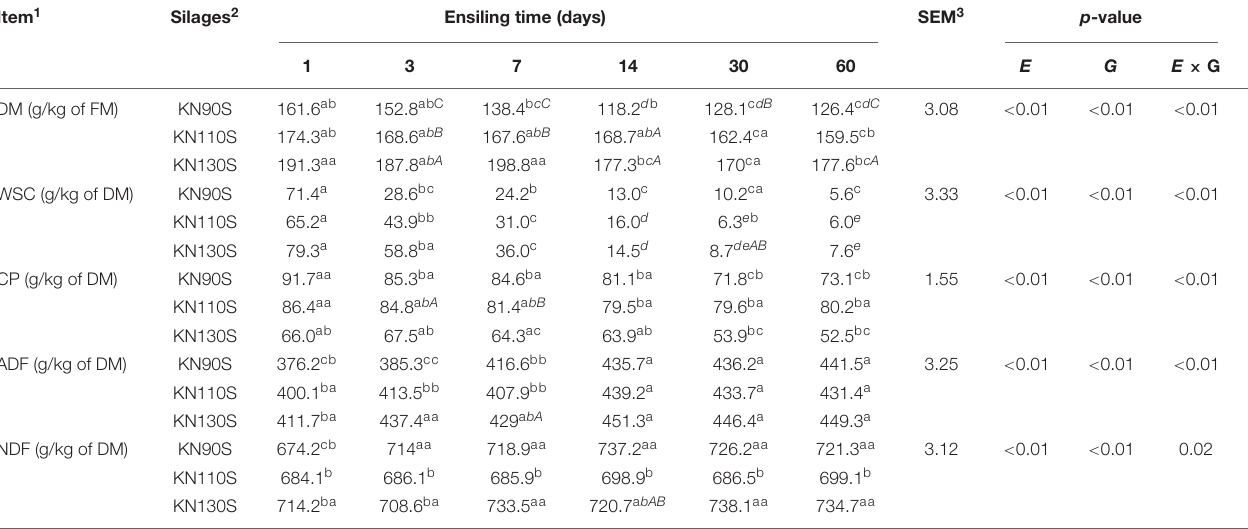
TABLE 2 | Changes in the chemical composition of king grass silage during ensiling.